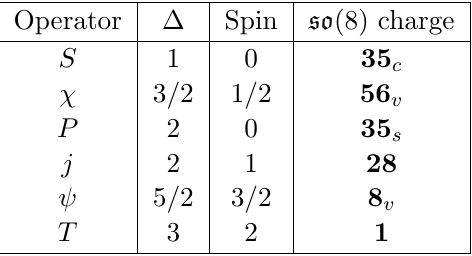
Table 1 . Operators in the N = 8 stress energy tensor